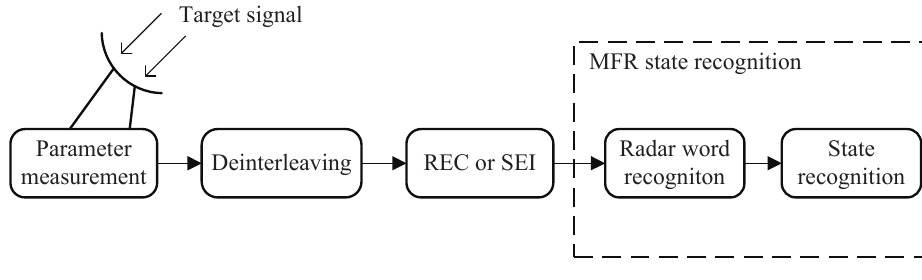
Figure 2. MFR state recognition